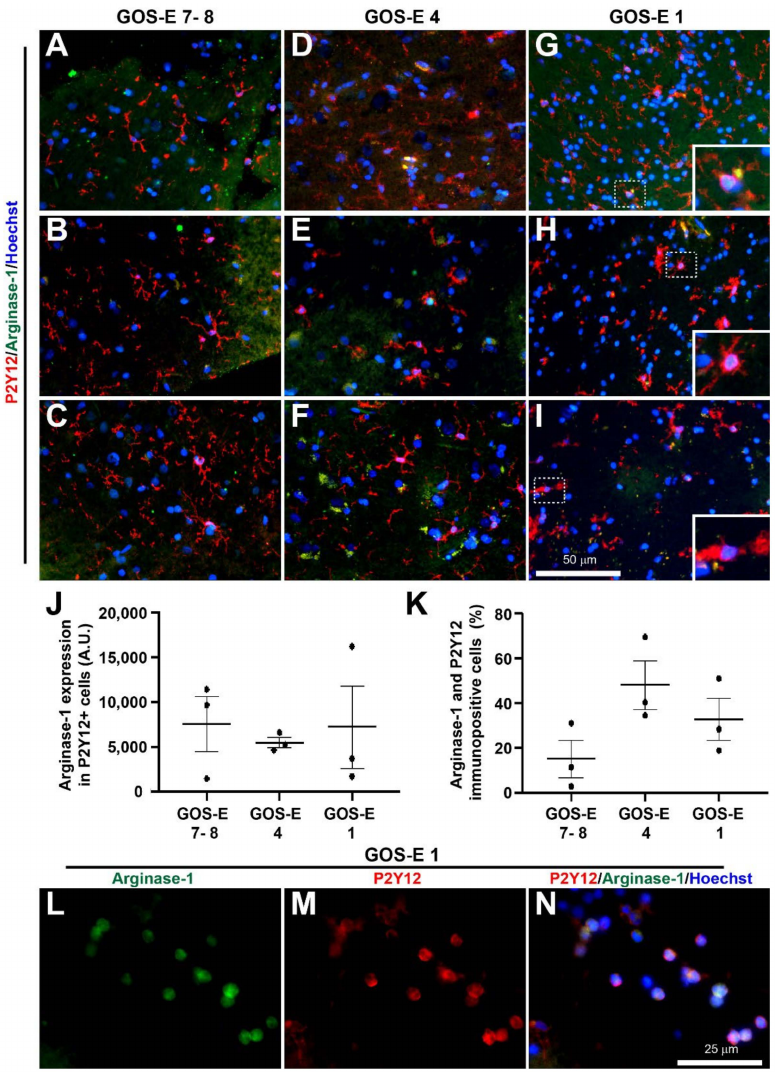
Figure 10. Classical anti-inflammatory arginase-1 marker and P2Y12-immunoreactivity in brain biopsies after severe TBI. Microglia are stained using P2Y12 (red) and the classical anti-inflammatory marker are stained with arginase-1 (green). Photomicrographs of P2Y12 and arginase-1 immunos- taining in 3 individual biopsies from patients with a GOS-E 7–8 ( A – C ). Photomicrographs of P2Y12 and arginase-1 immunostaining in 3 individual biopsies from patients with a GOS-E 4 ( D – F ). Pho- tomicrographs of P2Y12 and arginase-1 immunostaining in 3 individual biopsies from patients with a GOS-E 1 ( G – I ). Inserts are enlarged dashed boxes showing cells with P2Y12 and arginase-1 co- expression ( G – I ). No significance between immunoexpression in the GOS-E groups detected for overall arginase-1 expression ( J ) and the number of arginase-1 and P2Y12 positive cells ( K ). A few circular cells with both strong arginase-1 and P2Y12 detected, only present in the GOS-E 1 group ( L – N ). Results represent mean ± SEM. N = 3 per group. Scale bars 50 µ m ( A – I ) and 25 µ m ( L – N ). Cellular nuclei stained with Hoechst